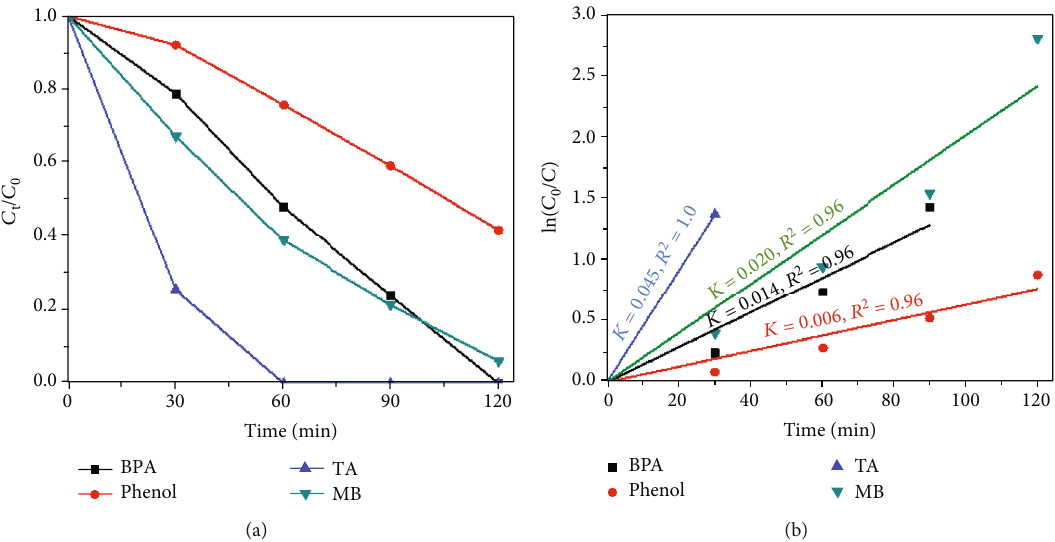
Figure 11: Degradation of the di ff erent persistent organic compounds in Ag/ZnO-10 composite. The reaction conditions are as follows: dosage catalyst of 0.05g, BPA concentration of 20 mg/L, and pH = 6 : 0 . Table 3: Comparison of photocatalytic degradation of BPA by various catalysts. Catalyst Reaction conditions